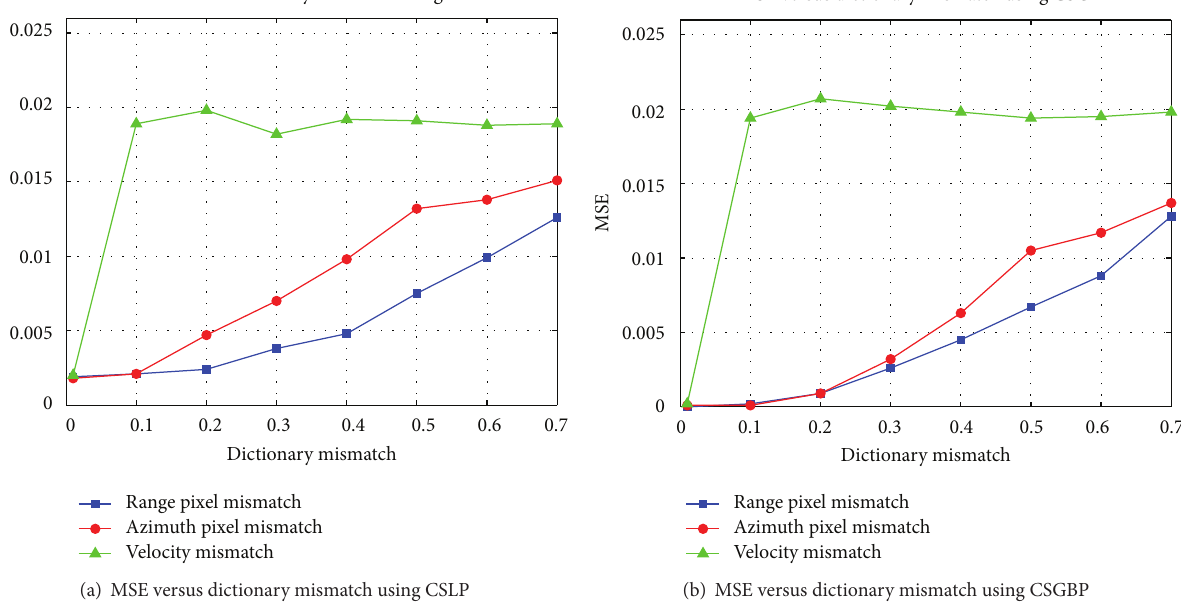
Figure 2: MSE versus dictionary mismatch using CSLP and CSGBP.